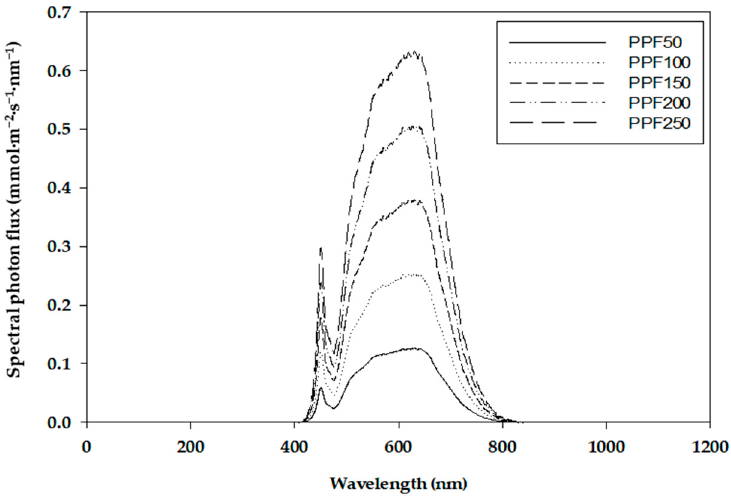
Figure 2. Changes of air temperature and relative humidity conditions applied in a PFAL.